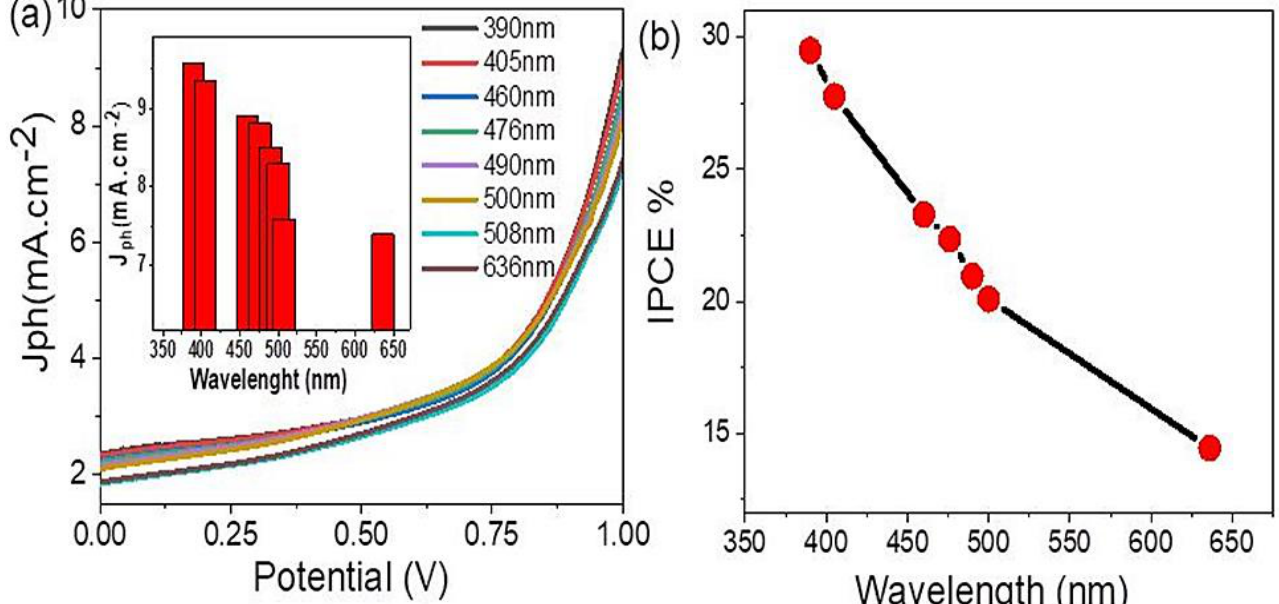
Figure 7. ( a ) The relation between the applied potential and the produced current density (the insert figure represents the relation between the applied wavelength and the produced current density at 1.0 V) and ( b ) the IPCE for the prepared Ag 2 O-Ag/Au/Al 2 O 3 photoelectrode.